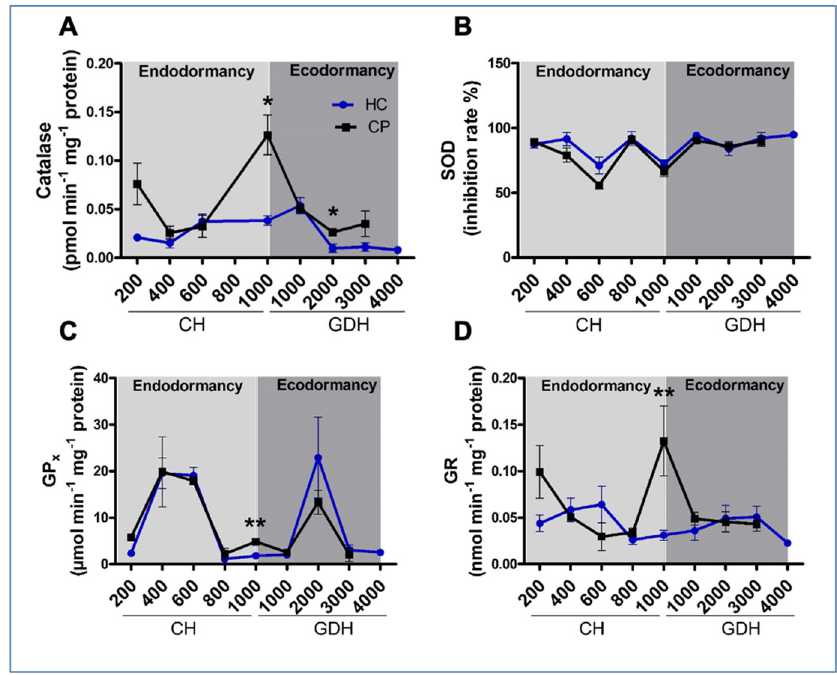
Figure 5. The enzymatic activities of catalase ( A ), superoxide dismutase, SOD ( B ), glutathione peroxidase, GPx ( C ) and glutathione reductase, GR ( D ) in two apple cultivars ‘Honeycrisp’ and ‘Cripps Pink’. Bud samples were collected from endodormancy induction to the bud break stage. Each point represents mean ± SEM of three biological replicates; p -value indicates comparison between ‘Honeycrisp’ and ‘Cripps Pink’ (* p < 0.05, ** p < 0.01,) using students t -test.